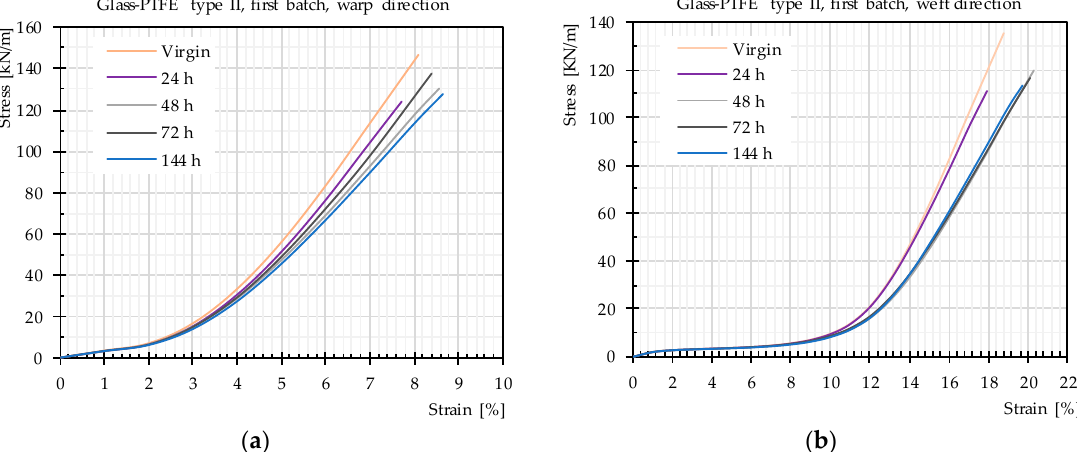
Figure 9. Stress–strain curves of glass-PTFE samples according to Table 3 for in-plane and out-of-plane watering: ( a ) warp direction and ( b ) weft direction.